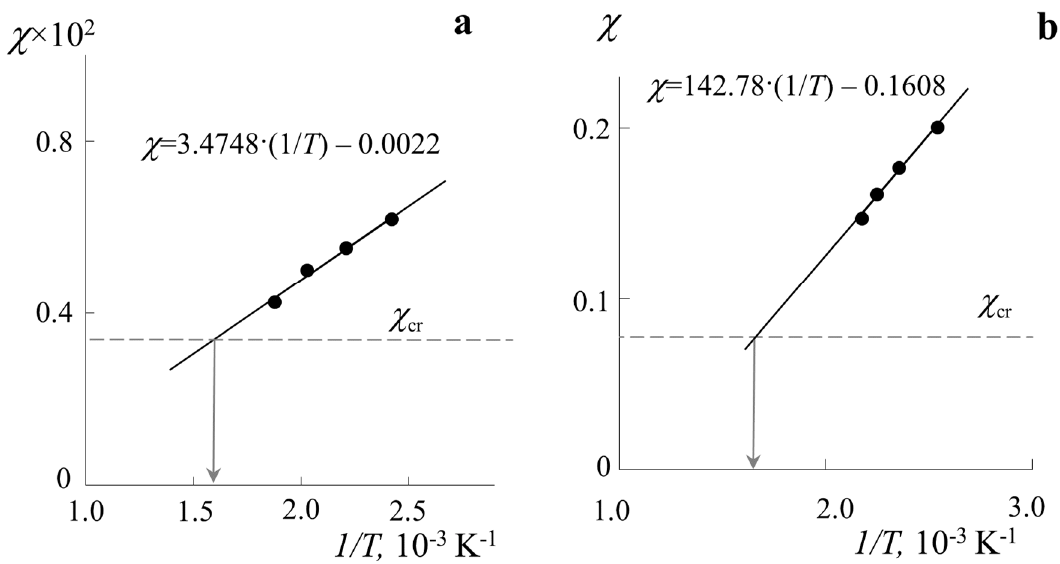
Figure 5. Temperature dependences of the Flory–Huggins parameter calculated by Equation (9) for PB–PS-1 ( a ) and PMMA–PS-2 ( b ) systems.